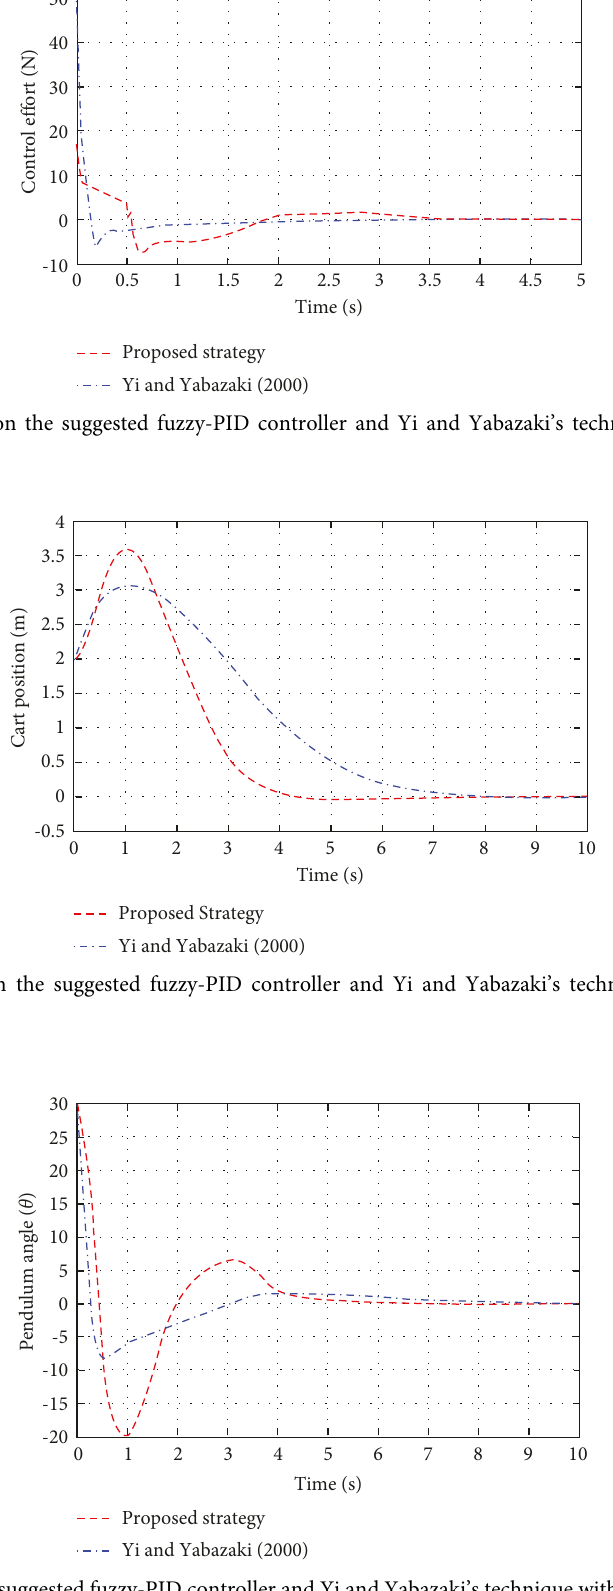
Figure 14: Pole angle based on the suggested fuzzy-PID controller and Yi and Yabazaki’s technique with [ 0 , 2 , 0 , 0 , π /6 , 0 ] initial